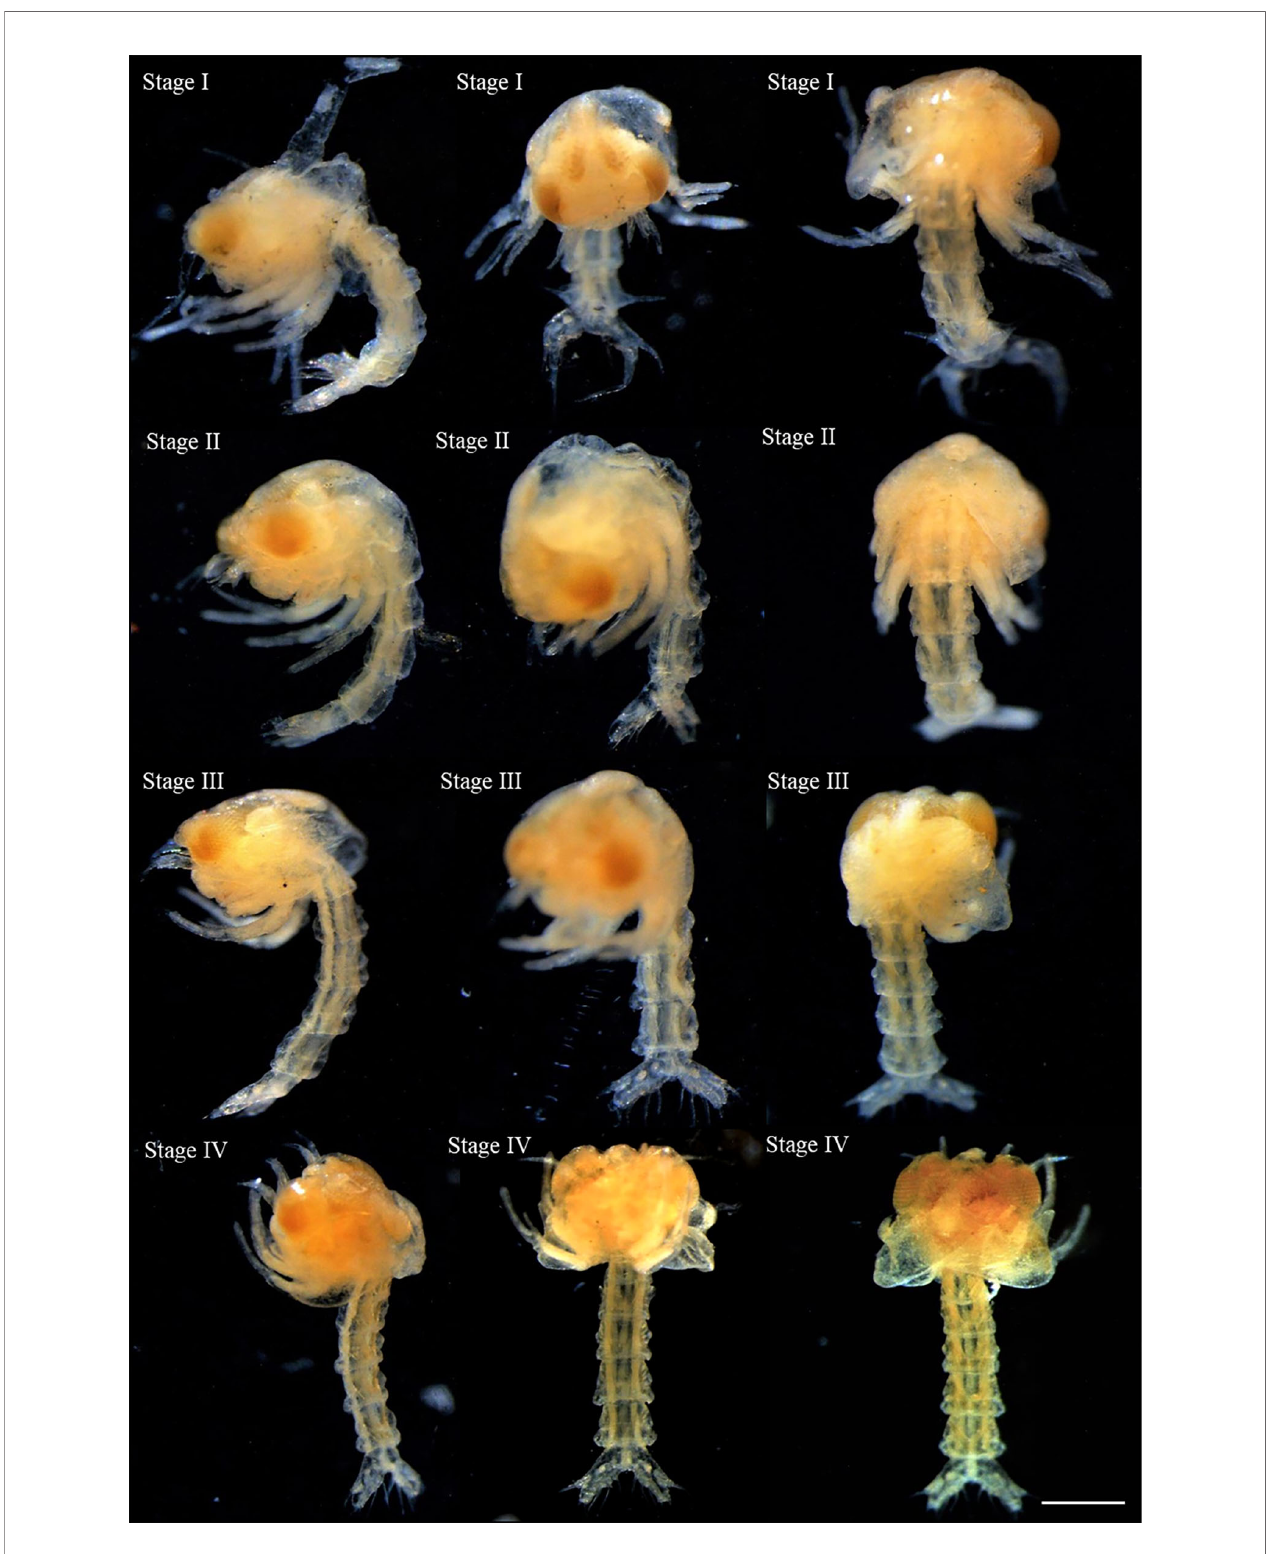
FIGURE 7 | The stages of larval development described for Segonzacia mesatlantica taken under Leica MZ16FA dissecting microscope. There are presently four stages of larval development (I, II, III, and IV) lateral view, ventral view, and dorsal view. Scale bars: I-IV = 200 m m.